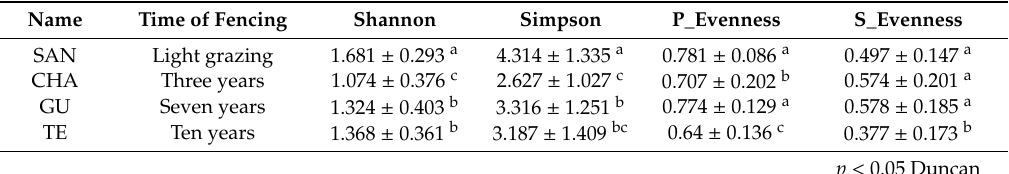
Table 1. Statistical analysis of the utilization patterns and α diversity indicators of the four sampling